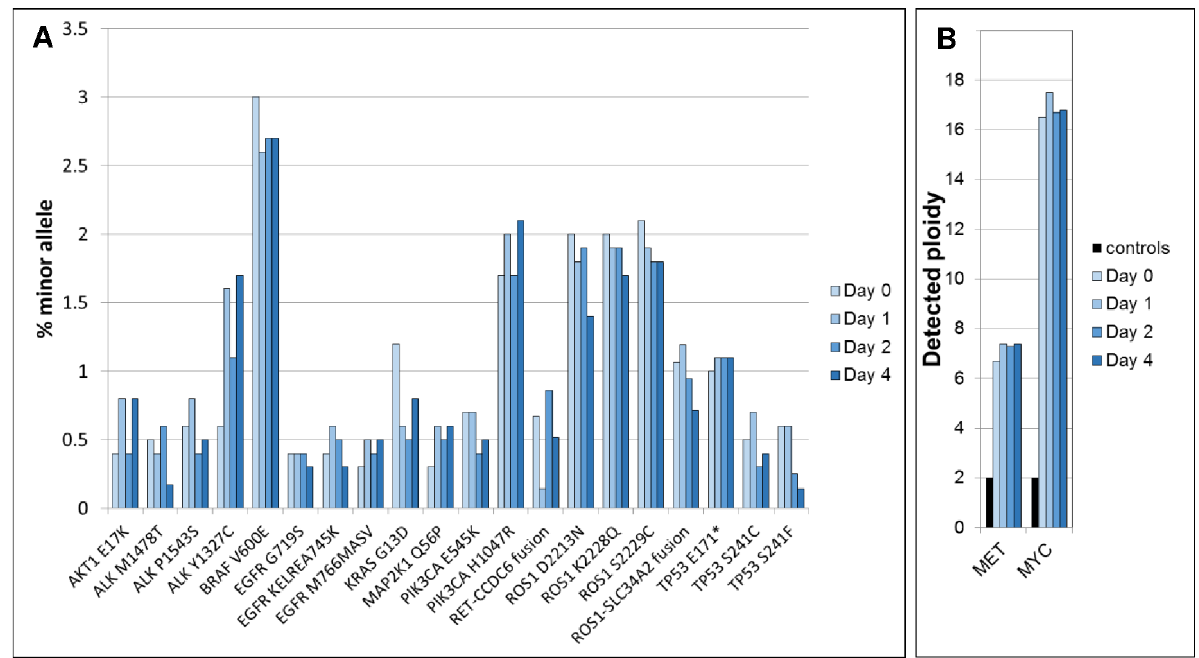
Fig 4. Stability testing of K2 EDTA plasma. (A) Mutation calls in four samples stored for 0, 1, 2 or 4 days at room temperature. The gene panel used detects 20 minor variants in the HD786 structural multiplex cfDNA reference standard, 12 of which are at or below0.5% minor allelefrequency. (B) Detection of copy numberamplification in MET and MYC genes as a function of plasma storage times.